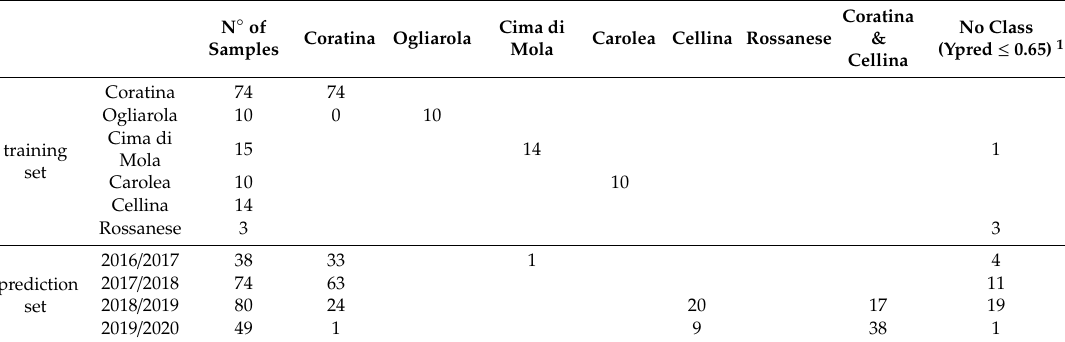
Table 2. Misclassification table summarizing the classified observations in the 2016 / 17, 2017 / 18, 2018 / 2019, and 2019 / 2020 prediction